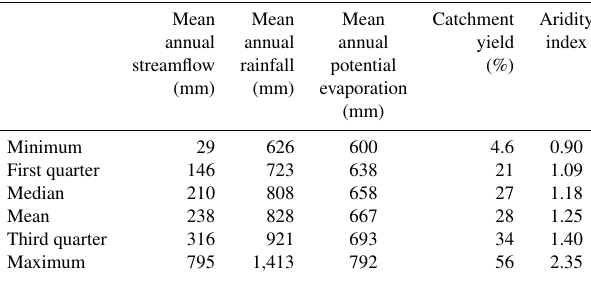
Table 2. Hydrological characteristics of the catchment dataset. The aridity index is defined as the quotient of annual rainfall and an- nual potential evaporation (PET). Catchment yield is the quotient of annual streamflow and annual rainfall. Mean Mean Mean Catchment Aridity annual annual annual yield index streamflow rainfall potential (%) (mm) (mm) evaporation (mm) Minimum 29 626